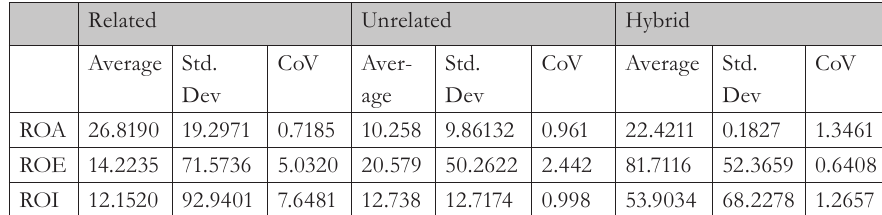
Tab. 2 – Comparison of ROA, ROE and ROI of Related, Unrelated and Hybrid Diversifica- tions. Source: own research